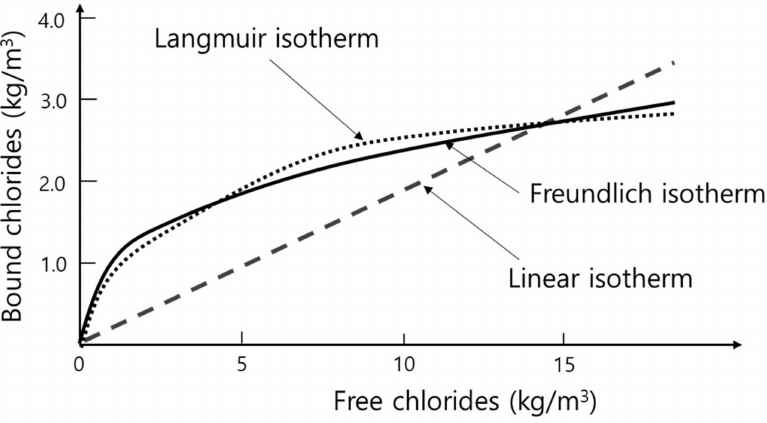
Figure 2. Comparison of Linear, Langmuir and Freundlich isotherm models